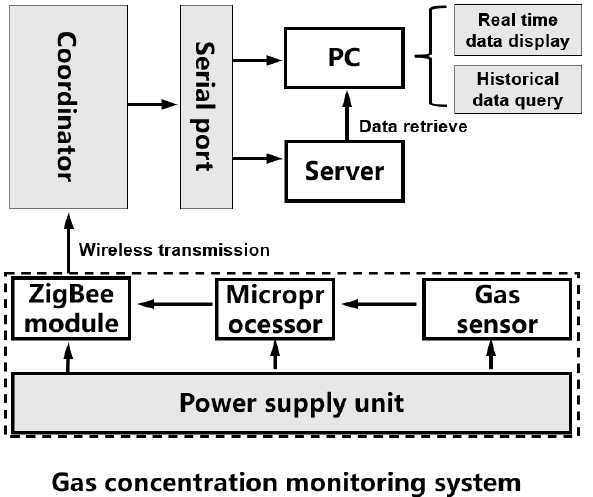
Figure 11. Structure and function diagram of the gas concentration monitoring system.